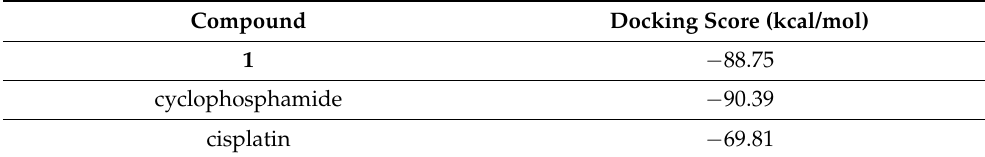
Figure 7. Interactions between the compounds (red dots) and B-DNA: 1 ( A ), cyclophosphamide ( B ), and cisplatin ( C ). Table 6. Ligand–receptor complex interaction energies with B-DNA